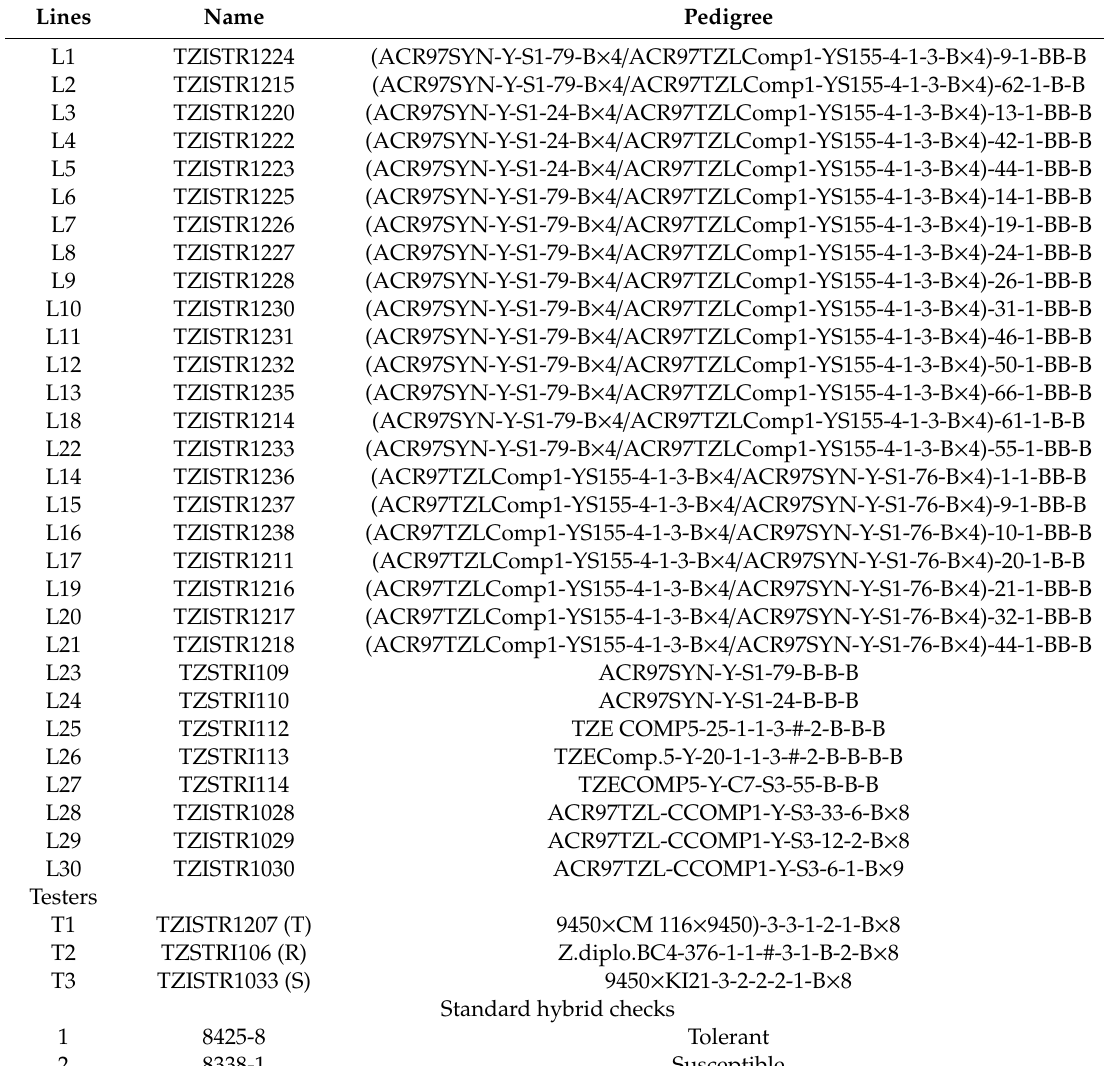
Table A1. Description of Striga -resistant inbred lines and the three testers used in the experiment.